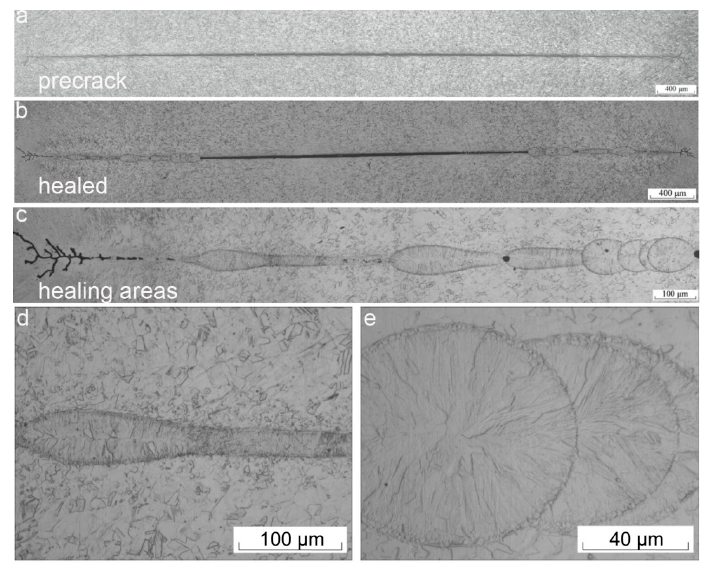
Figure 10. Morphology of healed cracks and healing areas: ( a ) pre-crack; ( b ) healed area; ( c ) healing areas; ( d , e ) partially enlarged view [125].